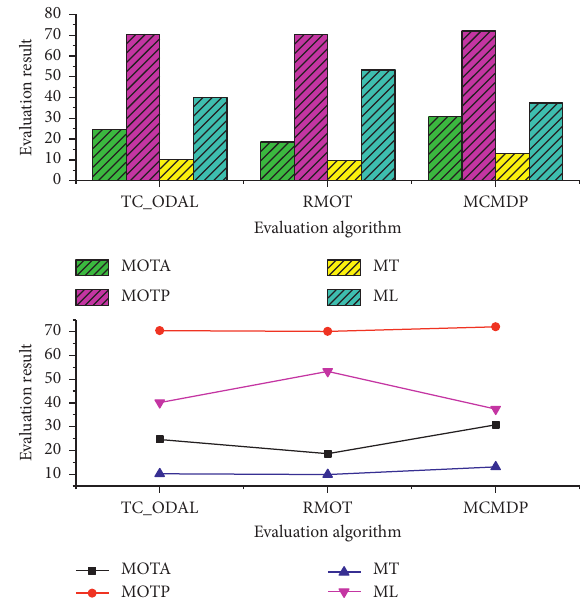
Figure 9: Evaluation results of the three methods of